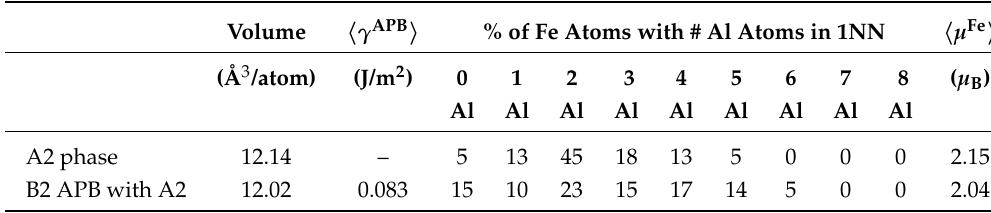
Table 2. Calculated properties of the studied atomic configurations of the A2 phase as a bulk and at the APB interface as a model for the thermally-induced APBs. The table summarizes volumes, APB energies, percentages of Fe atoms with different number of Al atoms (from 0 to 8) in the 1NN shell of the Fe atoms and the average value of magnetic moments Fe atoms (cid:104) µ Fe (cid:105) .